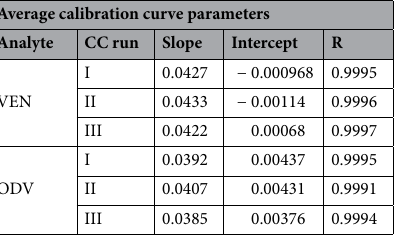
Table 5. Average CC parameters for VEN and ODV in rabbit plasma.